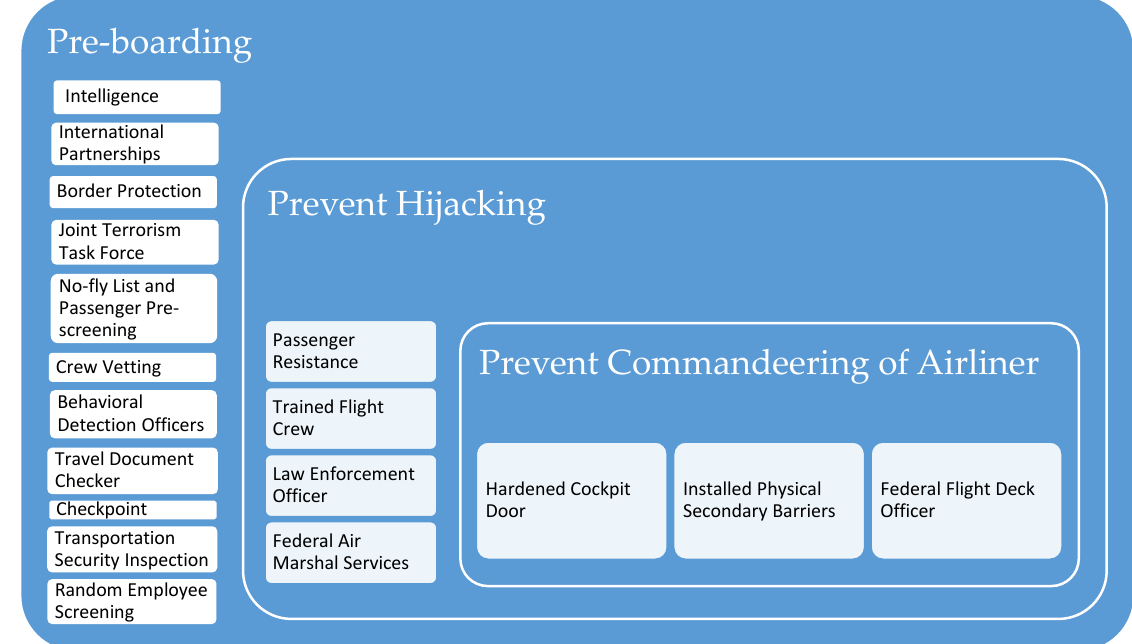
Figure 5. Layers diagram for aviation security measures (US security layers).